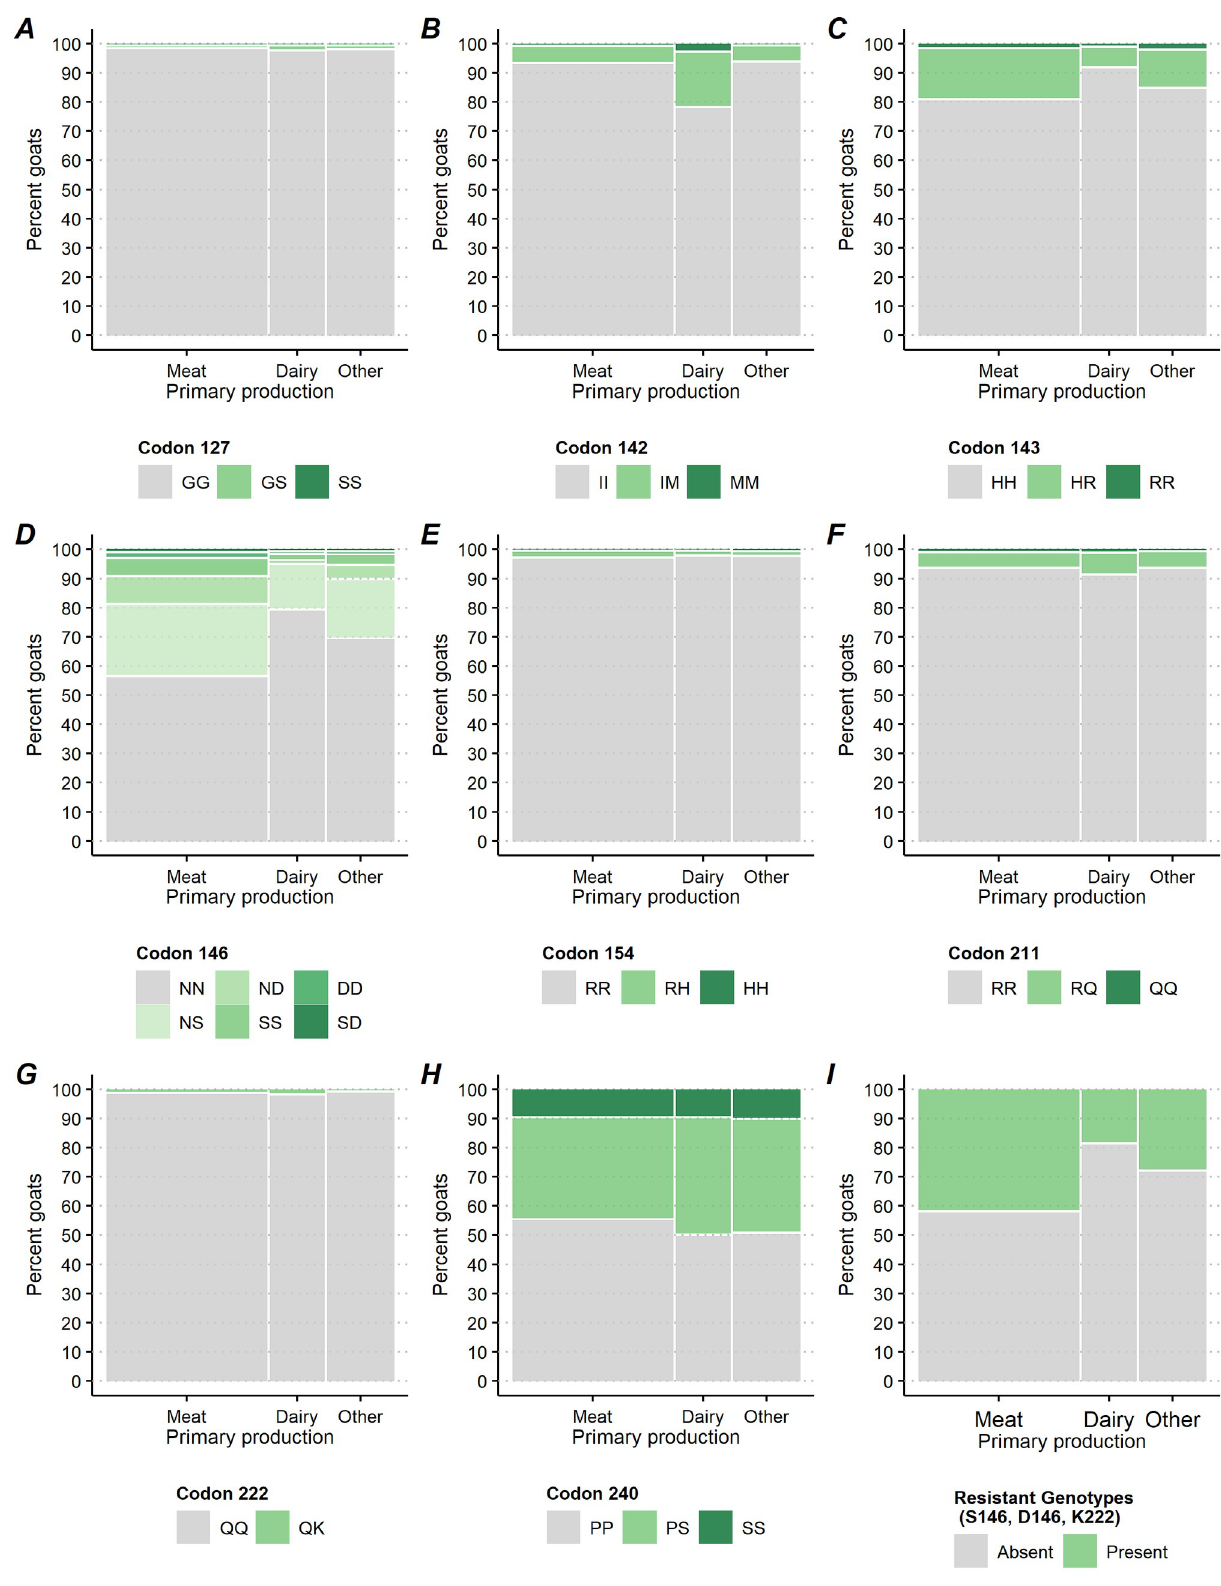
Fig 5. Percentage of goats by caprine PRNP polymorphic variants at codons 127, 142, 143, 146, 154, 211, 222 and 240 and by primary production types. https://doi.org/10.1371/journal.pone.0254998.g005 PLOS ONE | https://doi.org/10.1371/journal.pone.0254998 July 19,